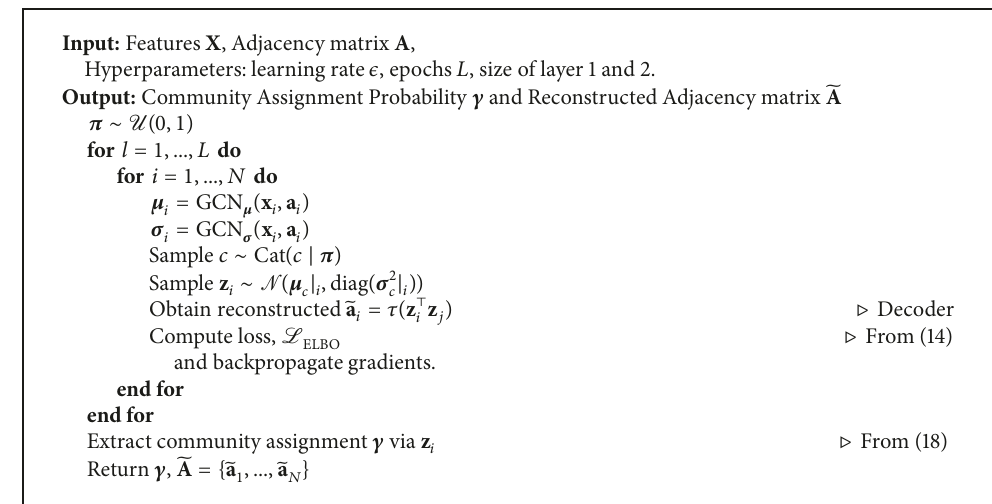
Algorithm 1: Variational Graph Autoencoder for Community Detection